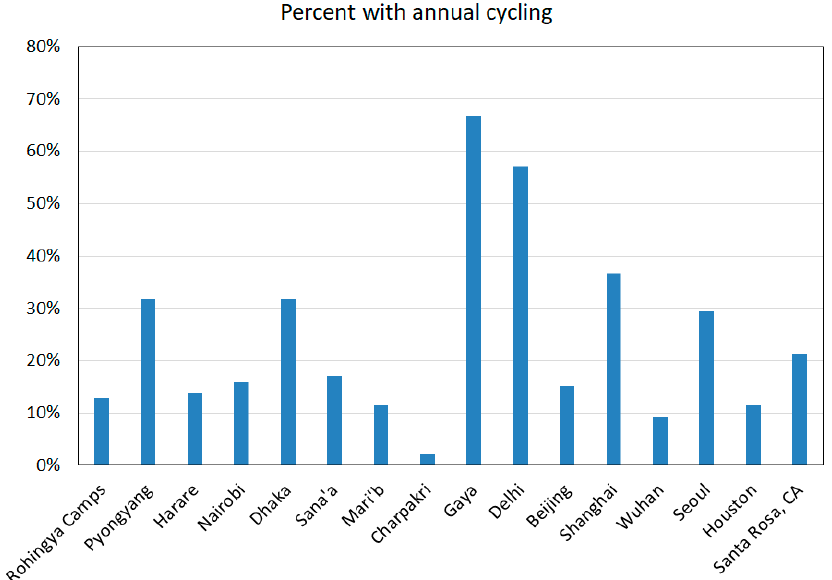
Figure 35. Picket-fence chart of the percent of grid cells with annual cycling for each of the test sites.